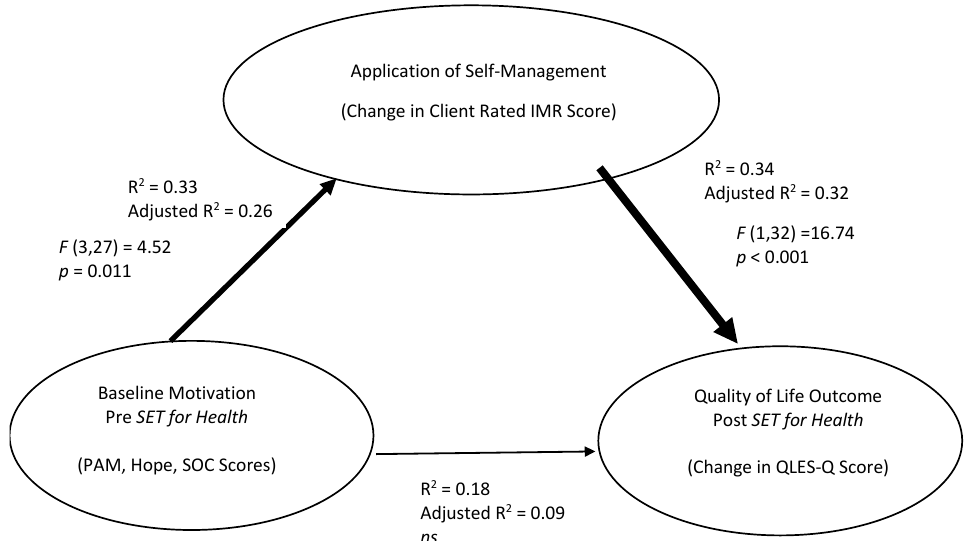
Figure 1. Participation in SET for Health as measured by improvement in client-rated IMR score mediates the relationship between baseline client motivation factors and improvements in client-rated quality of life outcome.